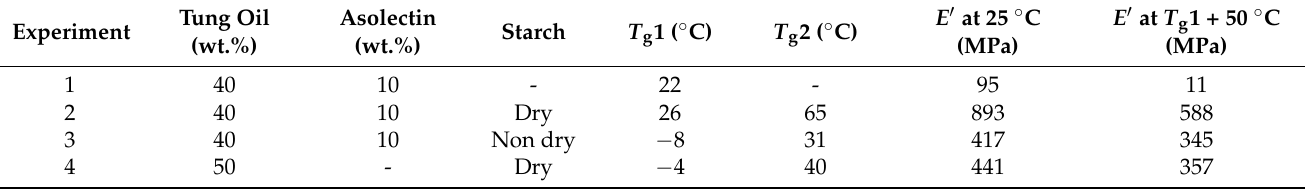
Table 3. DMA results of unreinforced resin and composites prepared with dry and not dry starch, and with or without asolectin. DVB and BMA content was kept consistent at 20 wt.% and 30 wt.%,